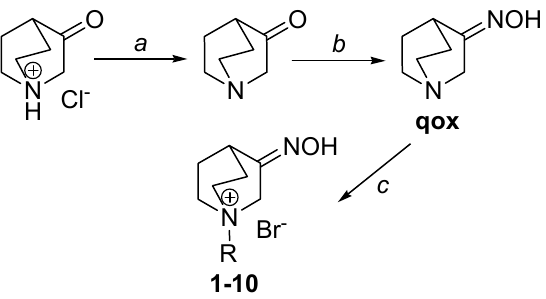
Figure 3. The synthetic route to target compounds. Reagents and conditions: ( a ) K 2 CO 3 , H 2 O, Et 2 O, 25 ◦ C, 30 min; ( b ) NH 2 OH × HCl, NaOH, MeOH, 25 ◦ C, 1 h; and ( c ) alkyl / aryl bromide, THF, Et 2 O, 66 ◦ C, 5 h.